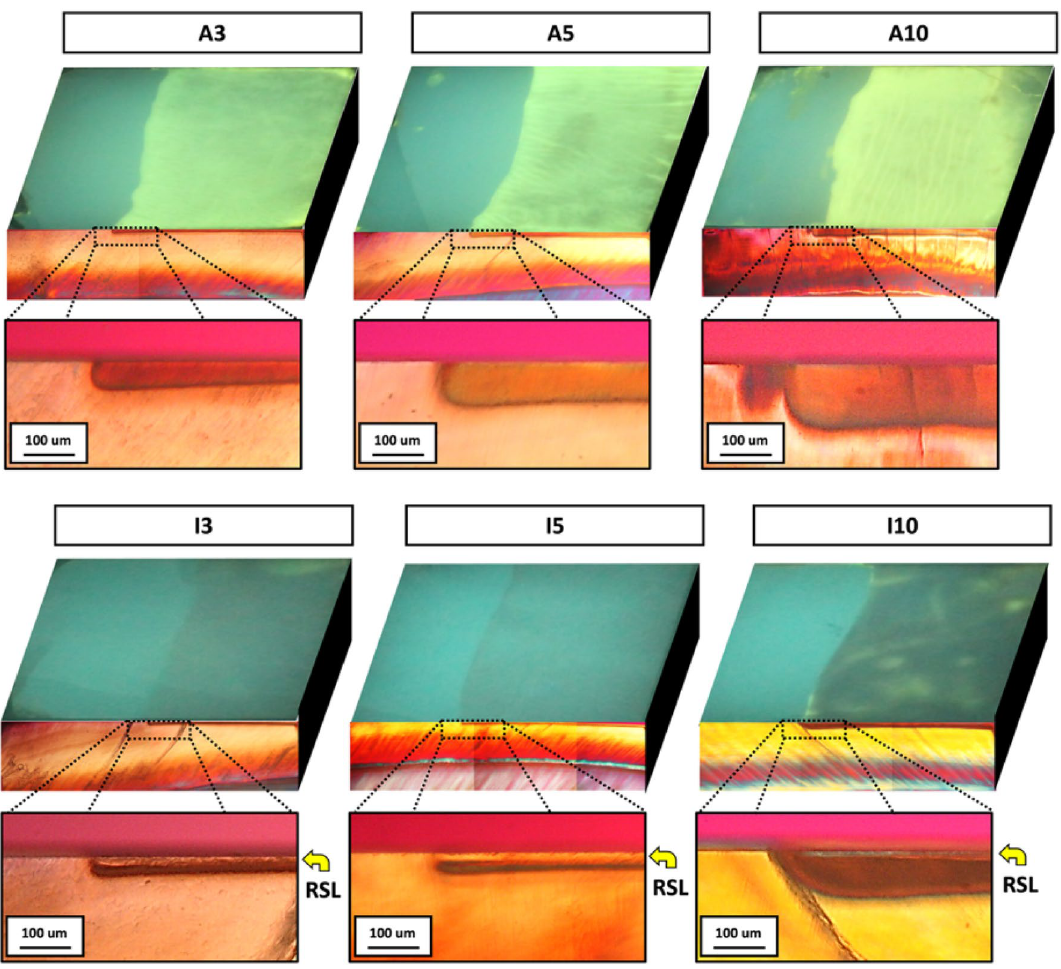
Figure 1. Representative images of the dyed specimens between the active (A X ) and the inactive (I X ) groups. Fluorescence images (top view) and the respective polarized-light micrographs (cross-sectioned view, 100 × of magnification). A X indicates active lesions that demineralize for X days; I X indicates inactive lesions that re-mineralize for 10 days after demineralization for X days. RSL indicates surface layer of remineralized caries lesion.